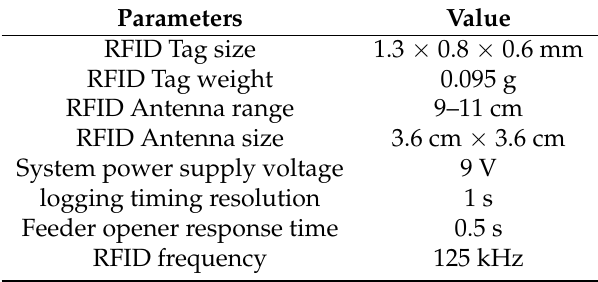
Table 1. Measured parameters of the proposed radio frequency identification (RFID) smart